Question: Provide a one-line summary of what is displayed.
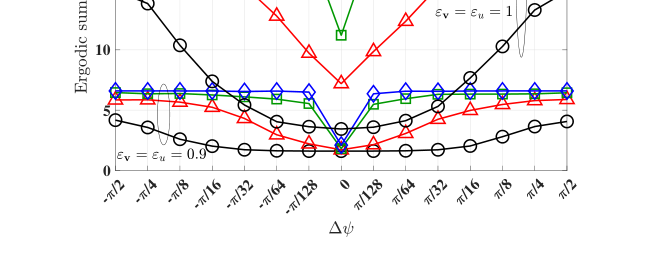
Answer: Simulation comparison of the ergodic sum-rate versus the AoA difference at the AP ∆ψ = ψr −ψt.